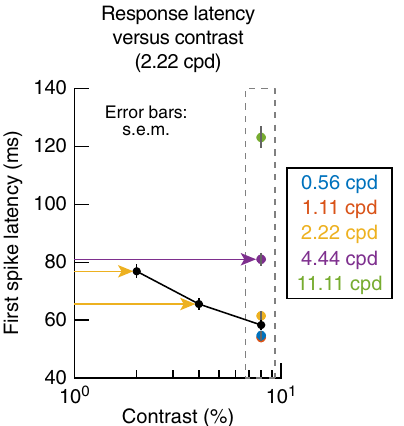
Fig. 5 Relationship between stimulus contrast and fi rst-spike latency in SC visual responses. For a population of neurons recorded from the same animals (Methods), we tested contrast sensitivity at 2.22 cpd, and we analyzed fi rst-spike latency as a function of grating contrast (black curve). Since lower contrasts were associated with lower visually evoked fi ring rates 25 , this also resulted in longer fi rst-spike latencies than with 80% contrast gratings (black curve). However, despite this, even these longer latencies were still shorter than the fi rst-spike latencies observed for 4.44 cpd gratings with 80% contrast (the colored dots surrounded by a dashed gray box show the same fi rst-spike latency data from Fig. 4, testing the effect of spatial frequency on fi rst-spike latency at 80% grating contrast; latencies for 4.44 cpd were still longer than latencies for 2.22 cpd, even when the latter had only 20% contrast). Thus, even with only 20% or 40% contrast, fi rst-spike latency for 2.22 cpd was still shorter than fi rst-spike latency for 4.44 cpd at 80% contrast. This means that the increased fi rst- spike latencies that we observed at 4.44 cpd (with high-contrast gratings) were not necessarily due to reduced sensitivity for such gratings. The great majority of neurons used in this fi gure had preferred eccentricities <15 deg (Fig.